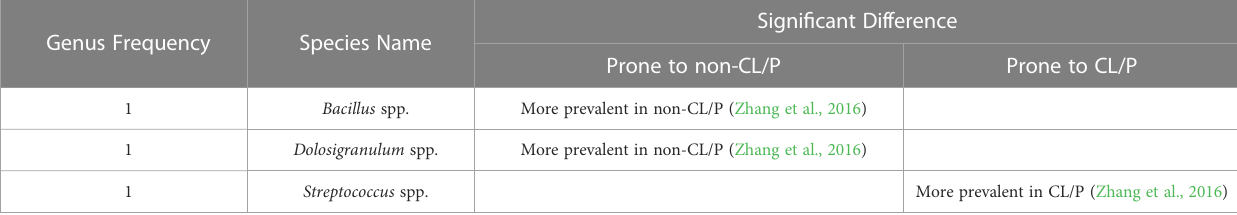
TABLE 2 Signi fi cant differences in bacterial species obtained from the nasal mucosa of CL/P and non-CL/P patients.